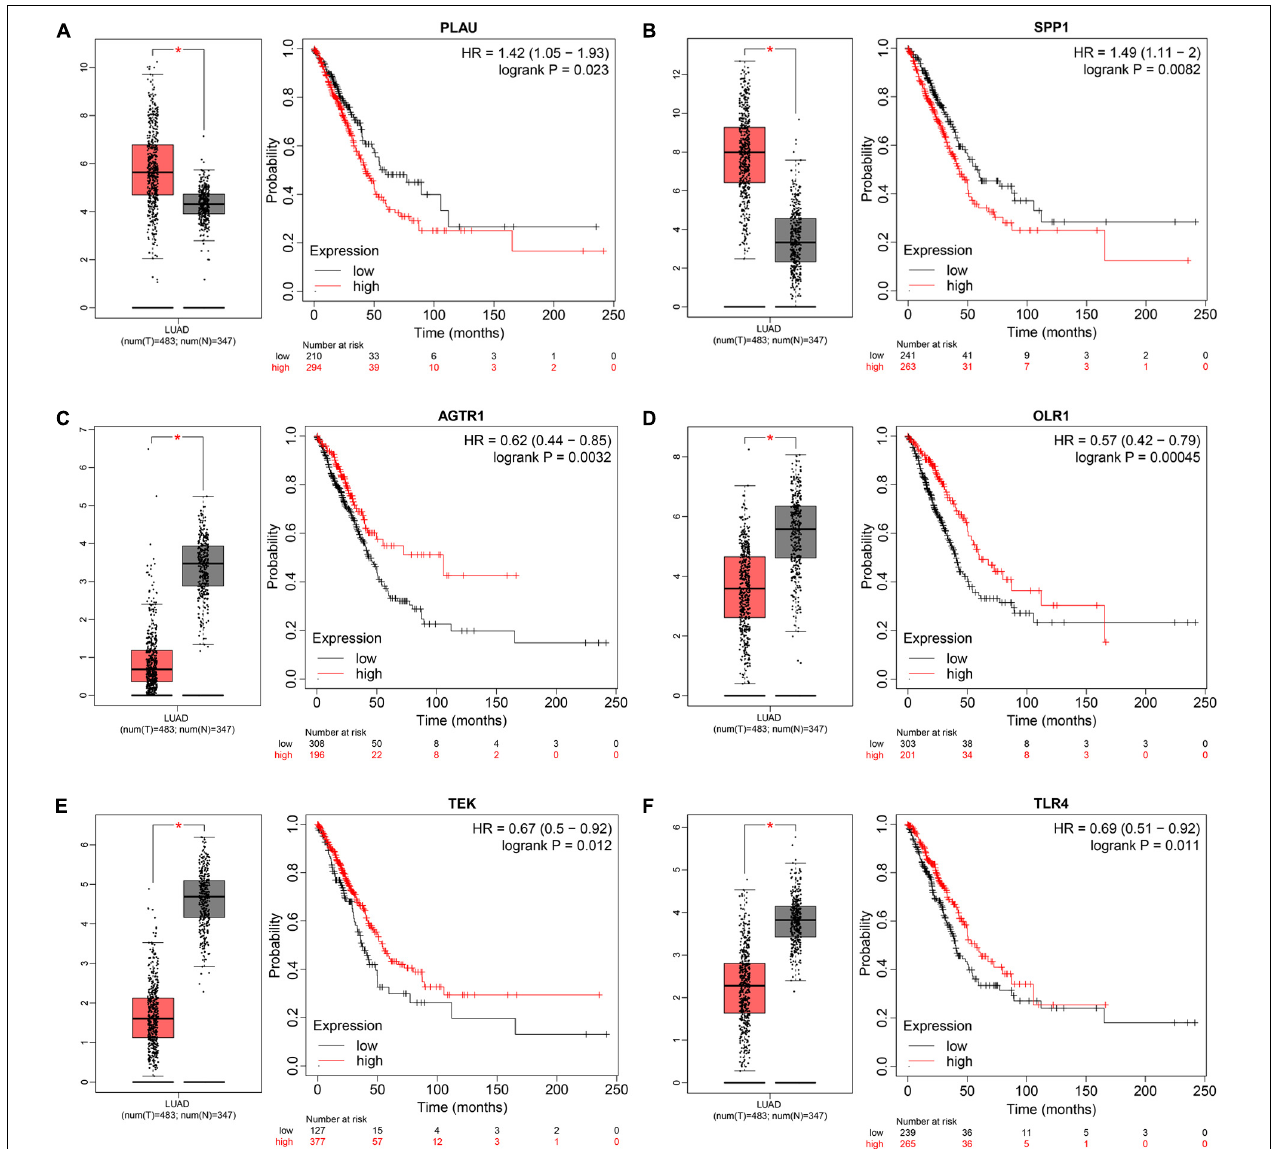
FIGURE 3 | Screening and validating the expression value and prognostic roles of hub IRGs in LUAD. (A–F) Validating expression roles and prognosis values of PLUA, SPP1, AGTR1, OLR1, TEK, and TLR4 through GEPIA and KM plotter, respectively (* P <